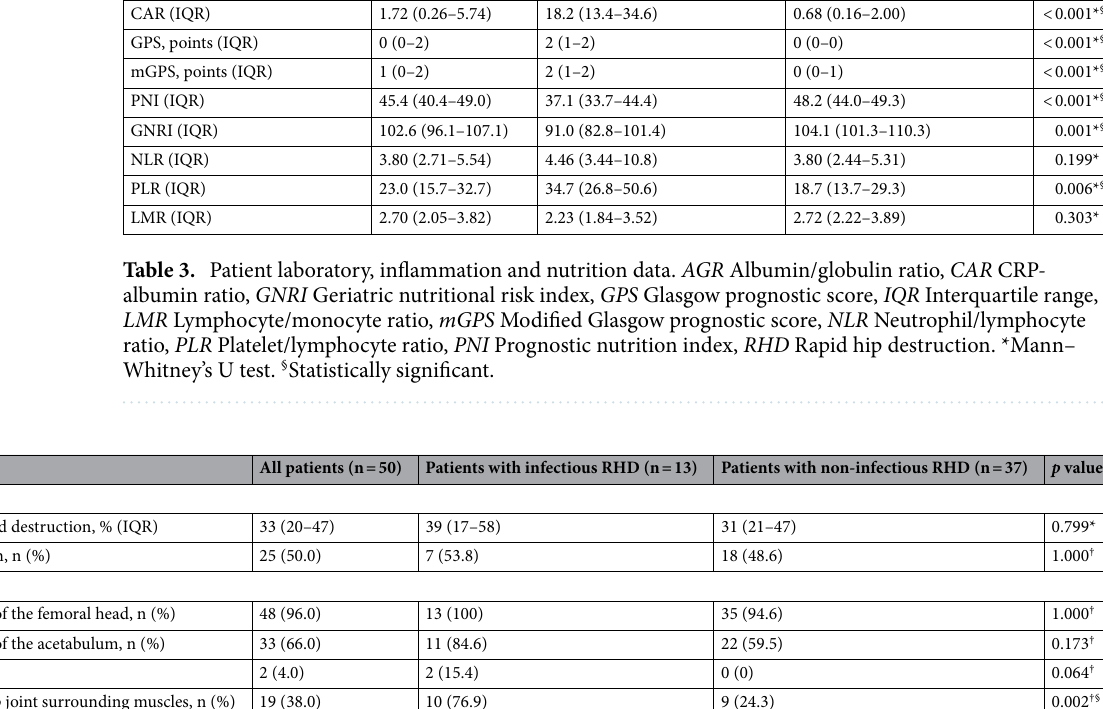
Table 4. Patient radiographical data. IQR Interquartile range, RHD Rapid hip destruction. *Mann–Whitney’s U test. † Fisher’s exact test. § Statistically significant.